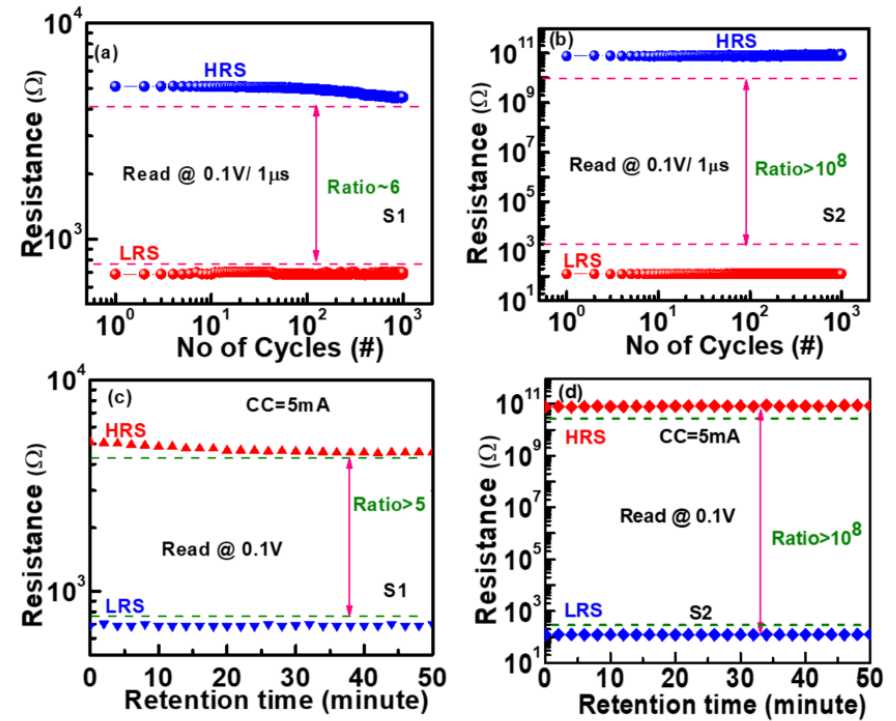
Figure 6. Read endurance characteristic of the ( a ) S1 and ( b ) S2 devices at read voltage of 0.1 V using 1 µs pulse width. Data retention characteristics of the ( c ) S1 and ( d ) S2 at CC of 5 mA using read voltage of 0.1 V.